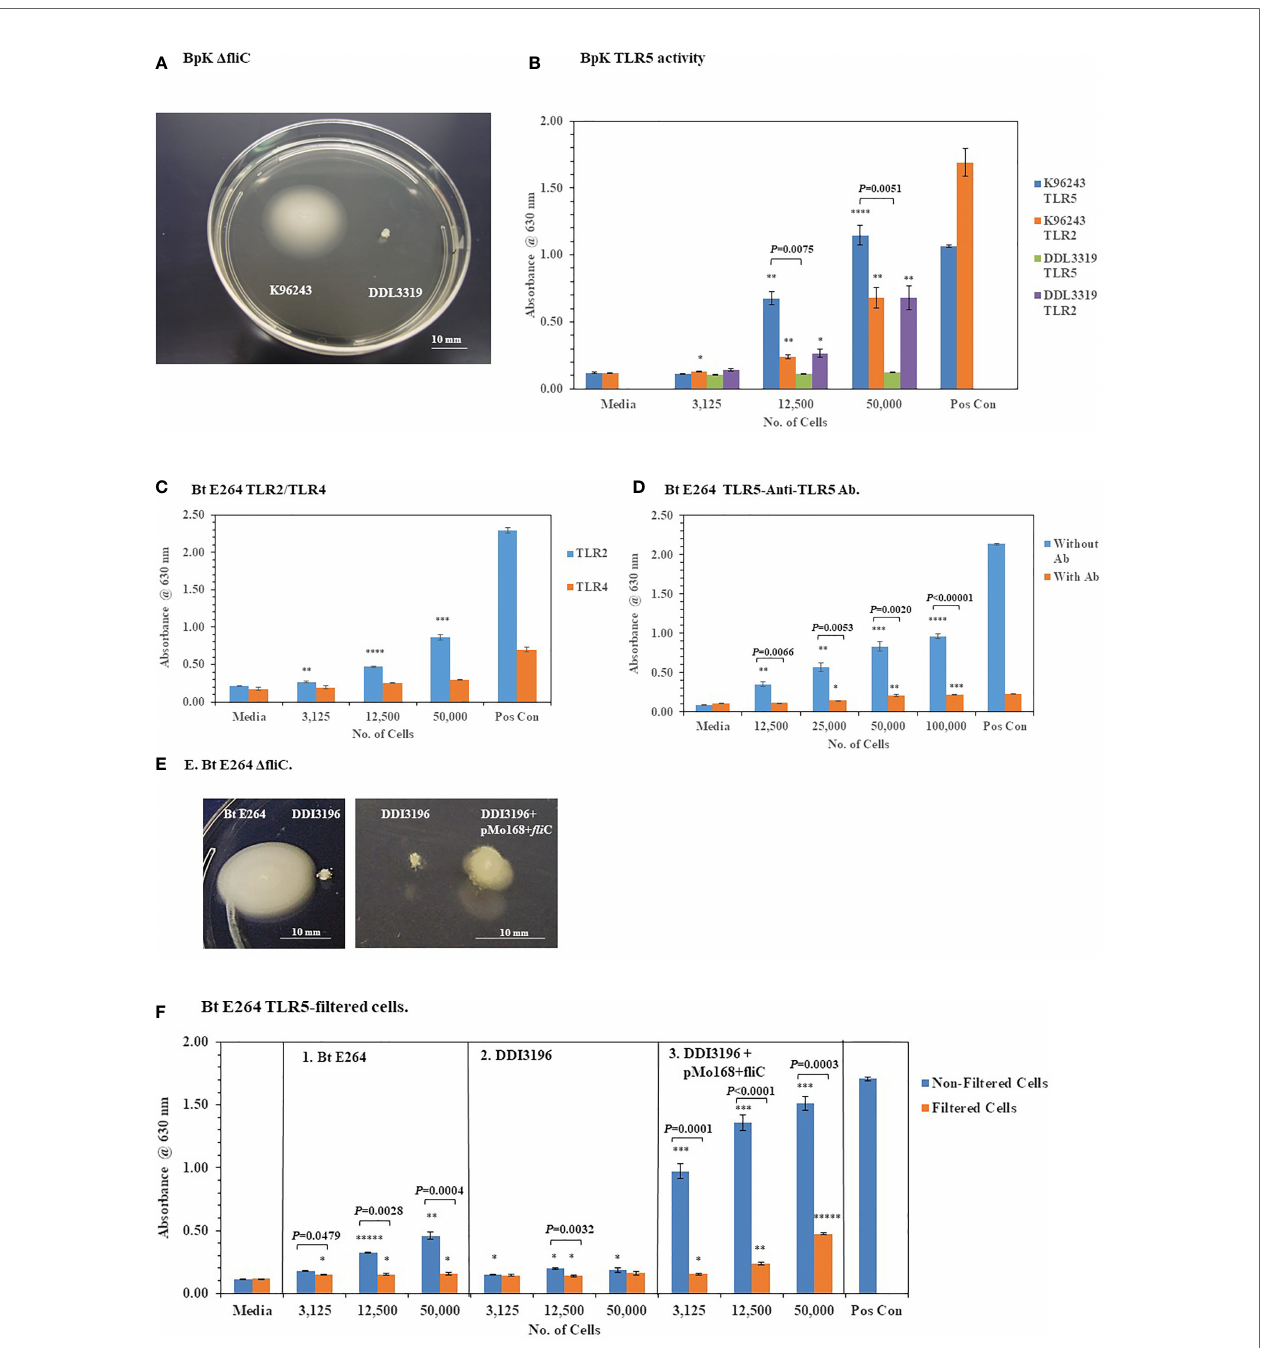
FIGURE 8 | Deletion of fl i C in pathogenic and nonpathogenic Bp strains abolishes TLR5 activation by the live microorganisms. (A) Wild-type Bp K96243 and fl i C mutant DDI3319 on motility agar after 24 h. (B) Loss of the ability to activate TLR5 by the fl i C mutant. Mutation in fl i C does not affect activation of TLR2 by the fl i C mutant. Signi fi cant differences in TLR5 activation by wild-type Bp K9624 and fl icC mutant DDI3319 is shown above the activity. (C) Nonpathogenic B. thailandensis E264 activates primarily TLR2 similar to BpK. (D) Anti-TLR5 antibody signi fi cantly inhibits TLR5 activation by live B. thailandensis E264. (E) Mutation of fl i C in B. thailandensis E264 (DDI3196) abrogates motility, but it can be partially restored (DDI3196+pMo168+ fl i C). (F) Filtration of B. thailandensis E264 abrogates TLR5 activation (panel 1). Filtration of cells and deletion of fl iC in B. thailandensis E264 both abolishes TLR5 activation (panel 2). In the partially recombinant DDI3196+ pMo168+ fl i C TLR5 activation is elevated, and TLR5 activity can be detected in the cell-free fi ltrate (panel 3). The media control was PBS, and positive controls (Pos Con) were St FliC (2 ng) for TLR5 and HKLM (2 x 10 6 cells) for TLR2. The activation of TLRs was analyzed in triplicate and results represent one of two independent studies. Results of TLR activation are presented as geometric mean with standard error of the mean. Signi fi cant differences between samples are shown above the results. Signi fi cant values compared to media control are shown: * P ≤ 0.05; ** P ≤ 0.01; *** P ≤ 0.001; ***** P ≤